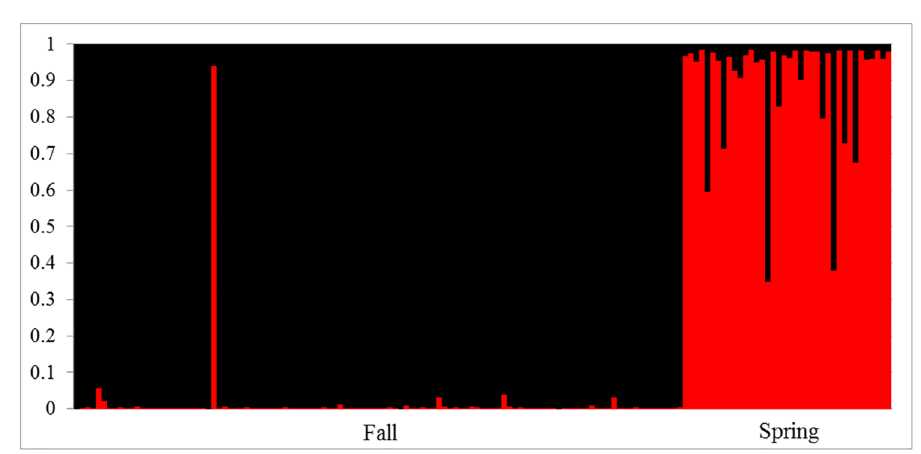
Fig 1. Results from Structure displaying the ancestry of fall spawning and spring spawning Atlantic sturgeon in the James River to K = 2 genetic clusters. Each individualbar representsthe ancestry of a singlefish, with the colors correspondingto the proportionof